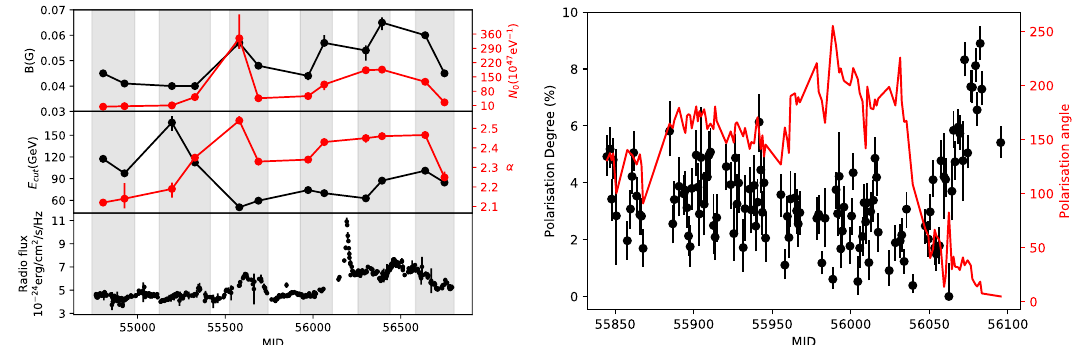
Figure3. TheevolutionoftheparametersoftheSED,withtheperiodschoseningray, withtheradio Figure 4. ( left ) The evolution of the parameters of the SED, with the periods chosen in gray, with the Figure4. Polarizationangleanddegree.TherotationoftheanglecanbeseenaroundMJD56040,right lightcurveonthebottomforcomparison. beforetheriseinthedegree. radio lightcurve on the bottom for comparison. ( right ) Polarisation angle and degree. The rotation of the angle can be seen around MJD 56040, right before the rise in the